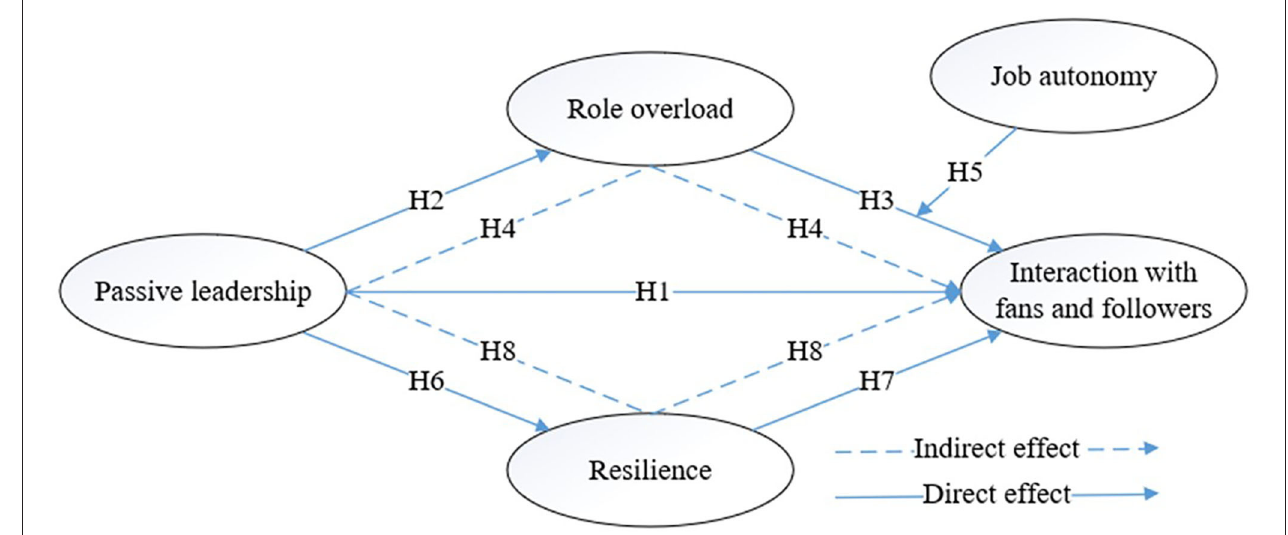
FIGURE 1 | Research model.